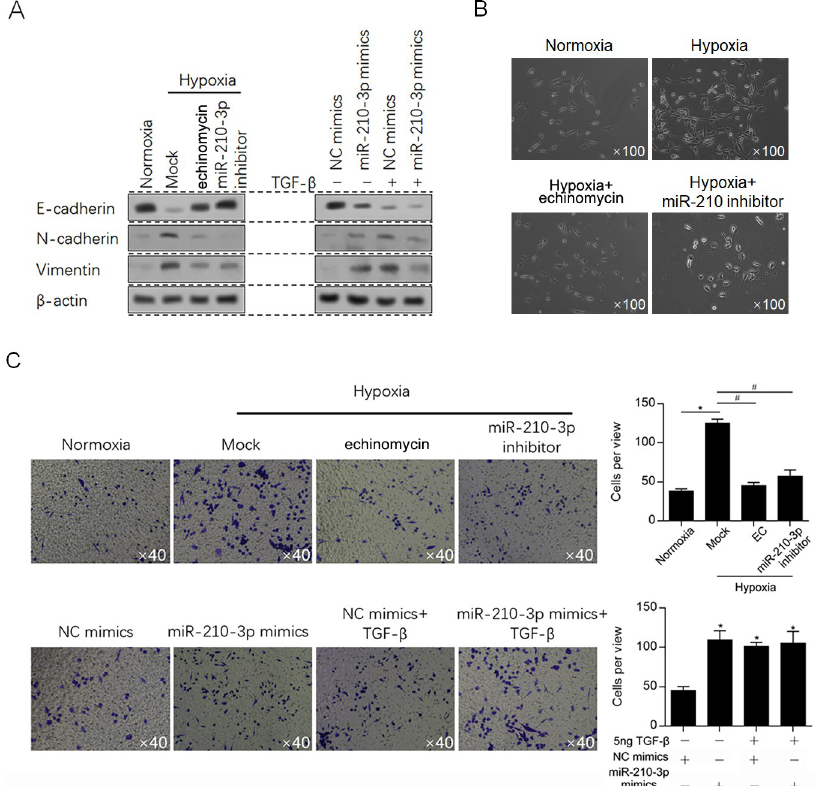
Fig 5. miR-210-3p promoted EMT potentially via regulating TGF- β . A. Western blot was performed to detect hallmarkers of EMT, including E-cadherin, N-cadherin and Vimentin. B. Morphological presentation of glioma U87MG cells after hypoxia exposure. C. Transwell assay was performed to detect the effects of miR-210-3p on invasive ability. For upper panel, � P < 0.05, vs. Normoxia group; # P < 0.05, vs. Hypoxia group. For lower panel, � P < 0.05, vs. NC mimics